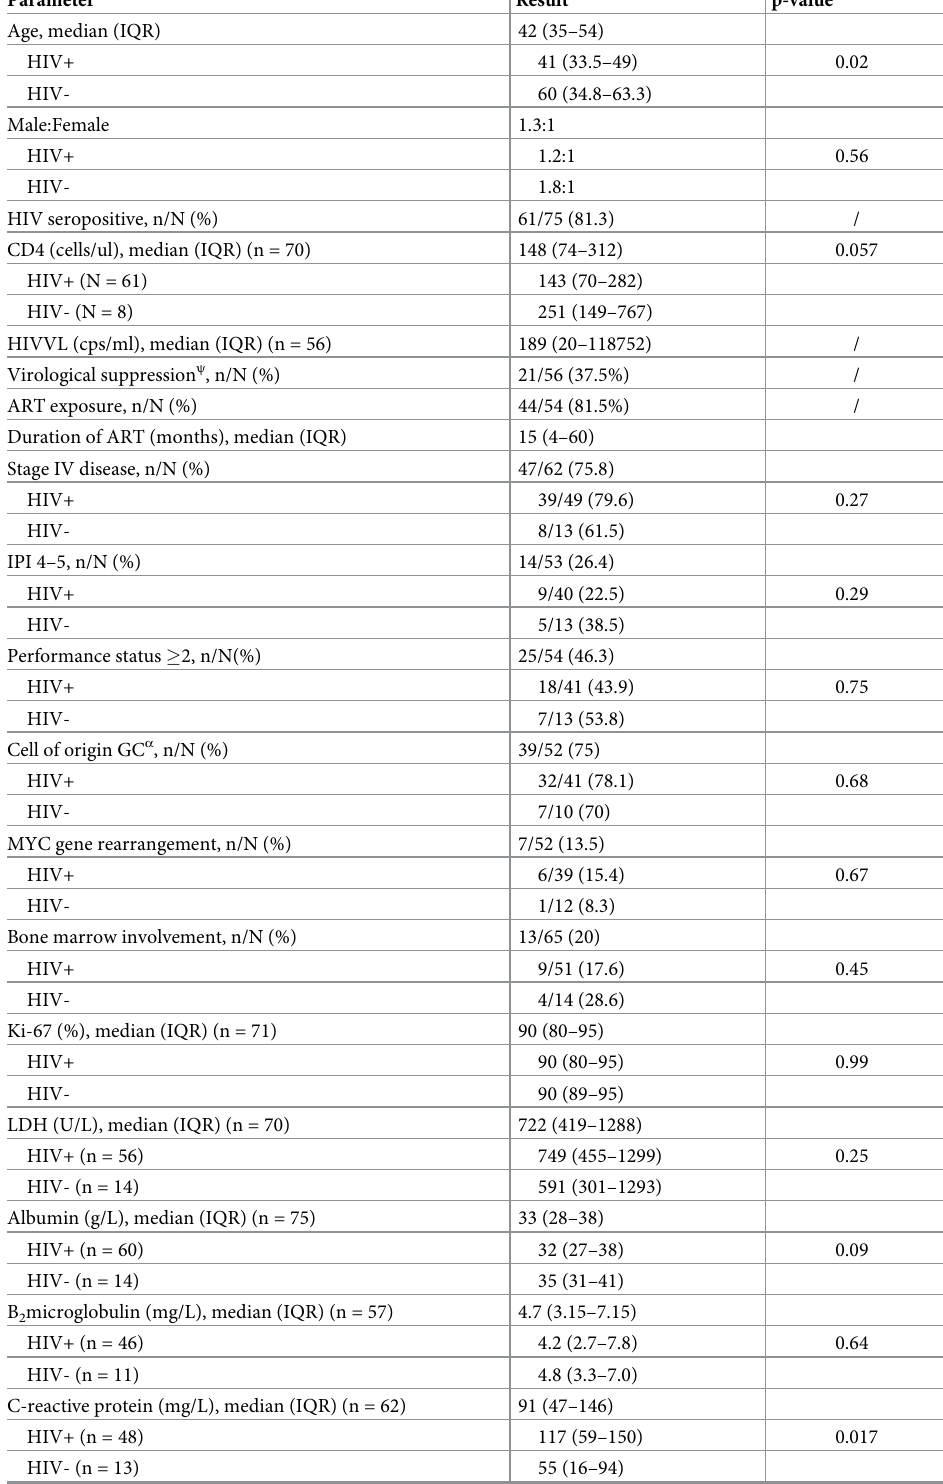
Table 1. Pertinent demographic, HIV-related and other laboratory